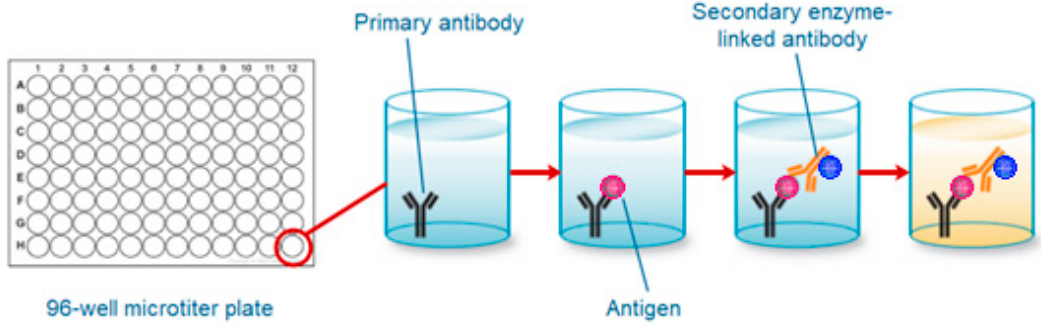
Figure 3. General procedure of ELISA technique.